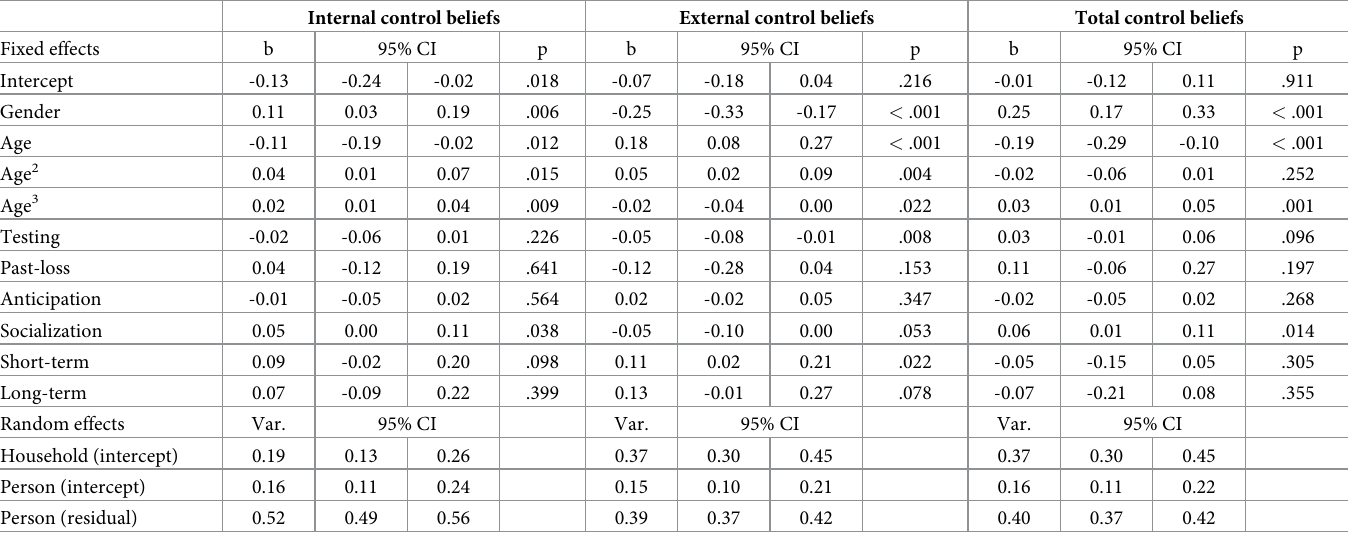
Table 7. Changes in perceived control before and after separation from a partner in individuals who experienced this loss between 1991 and 1999 ( N =